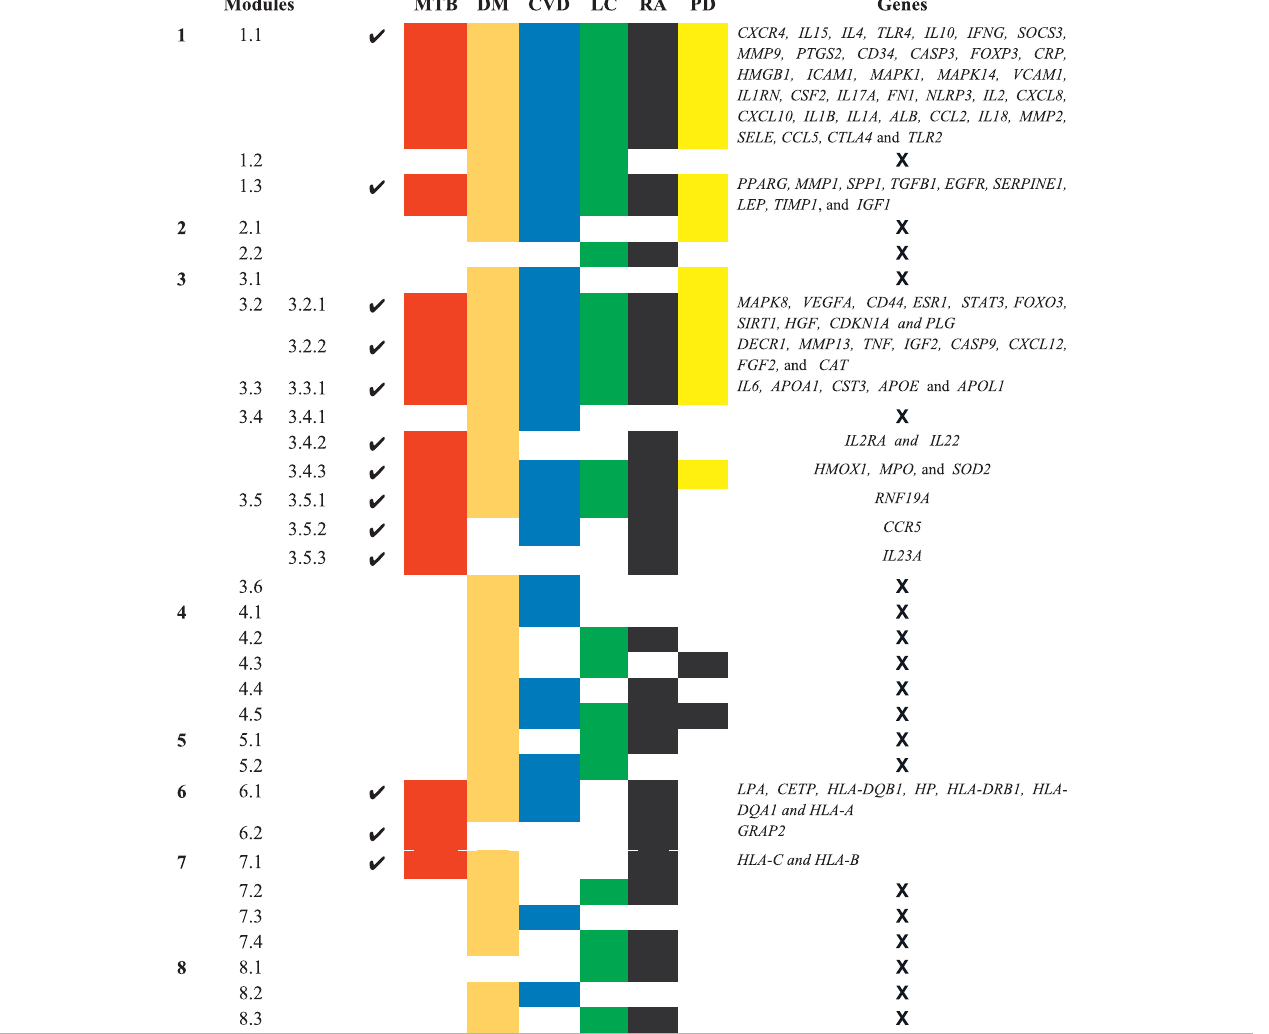
Frontiers in Pharmacology |